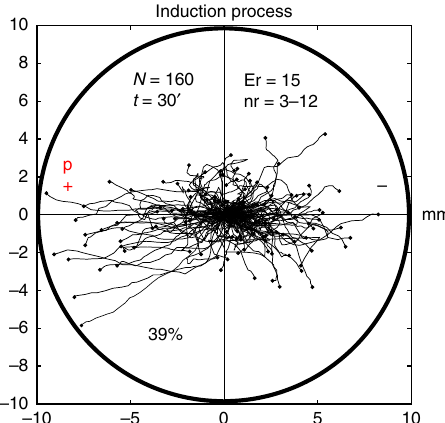
Fig. 9 Induction process in Metamoeba leningradensis . Under galvanotaxis and chemotaxis simultaneously, 39% of the Metamoeba leningradensis moved towards the anode-peptide (induced cells). “ N ” total number of cells, “ Er ” experimental replicates, “ nr ” number of cells per replicate, “ t ” galvanotaxis time, “ p ” chemotactic peptide (nFMLP), “ + ” anode, “ − ” cathode. The tracking has been represented up to the maximum value obtained towards the positive or negative pole. Both the x and y axis show the distance in